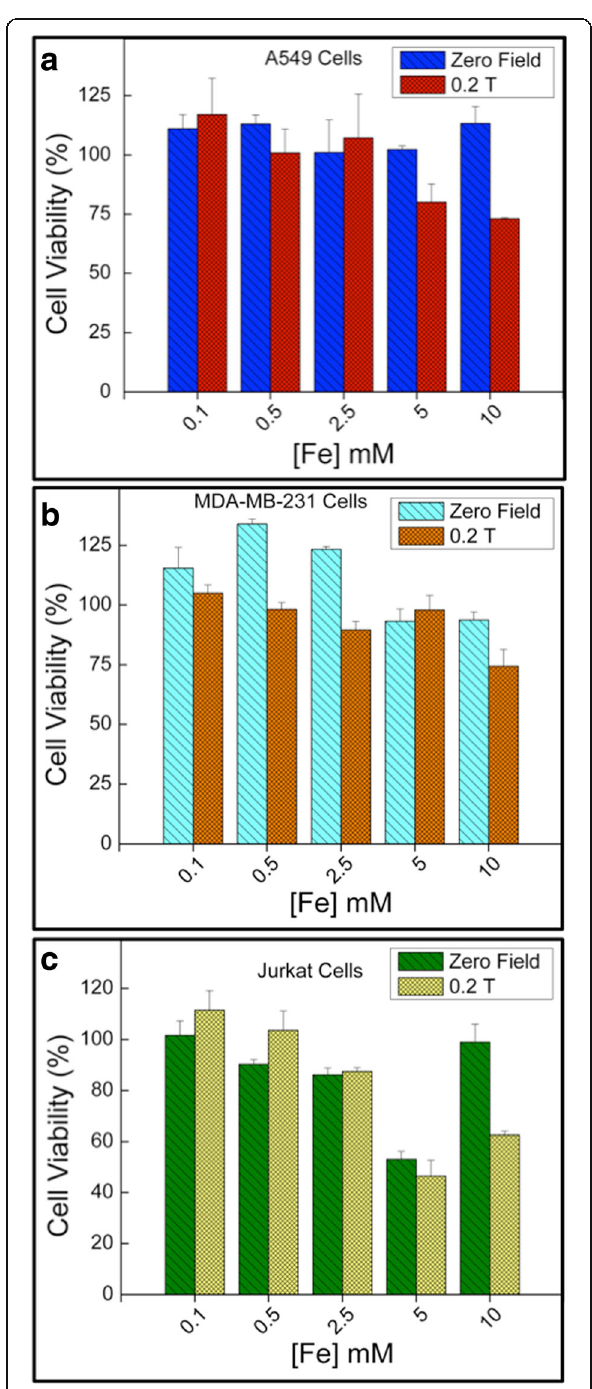
Fig. 8 In vitro MTS cytotoxicity assays showing the A495 ( a ), MDA- MB-231 ( b ) and Jurkat ( c ) cell viabilities in the presence of PEG-SPION at different concentrations after incubation for 24 h, and in absence and presence of an external static magnetic